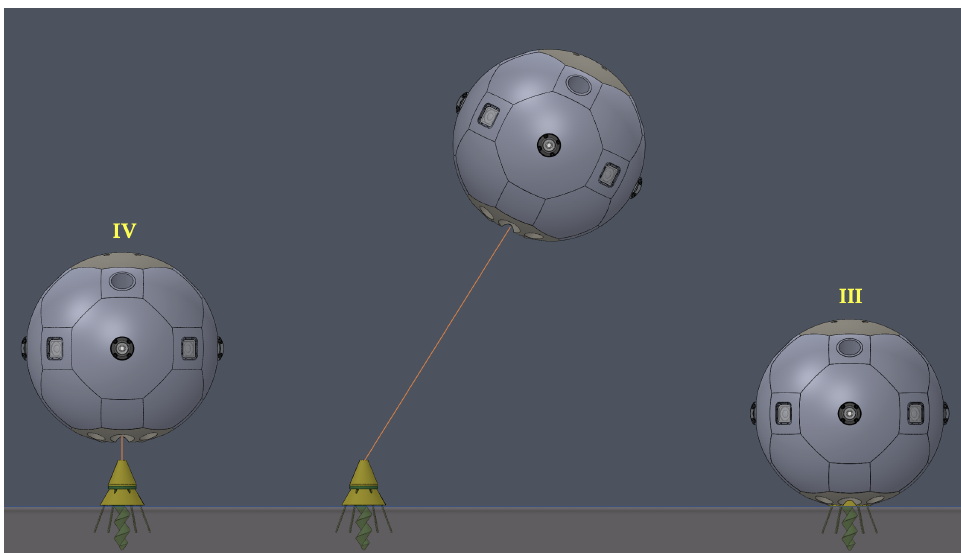
Figure 11. The RAATM tether may be payed out to control depth or antenna